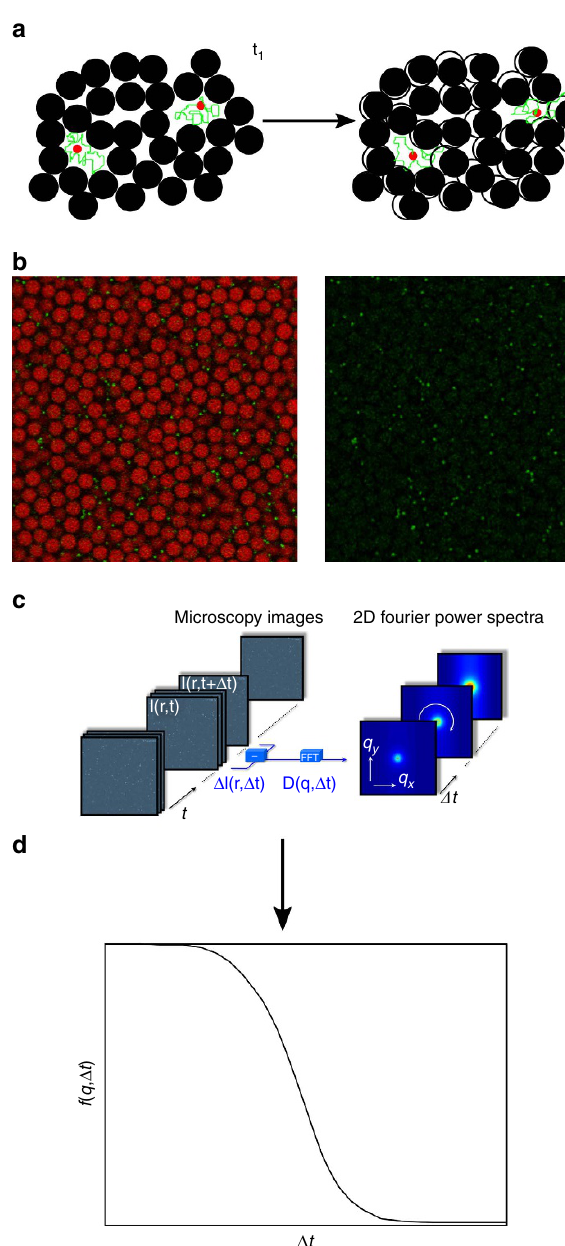
Figure 1 | Illustration of the system and measurement method. ( a ) Schematic illustration of our system at two times t 1 and t 2 4 t 1 highlighting the trajectories (green lines) of the intruders (red beads) in voids and between voids made possible due to the mobility of the matrix particles. ( b ) An exemplary confocal microscopy image of a mixture with d ¼ 0.18 and f ¼ 0.58 in which (left) both particles and (right) only the small particles are shown. ( c ) Image differences D I ( r , D t ) at different delay times D t are Fourier transformed to give 2D Fourier power spectra for different D t . ( d ) After azimuthal averaging and additional treatment the intermediate scattering function f ( q , D t ) is